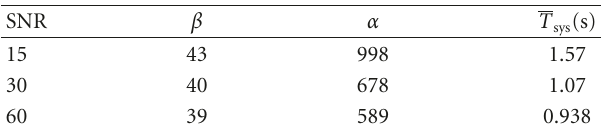
Table 2: T sys versus SNR.